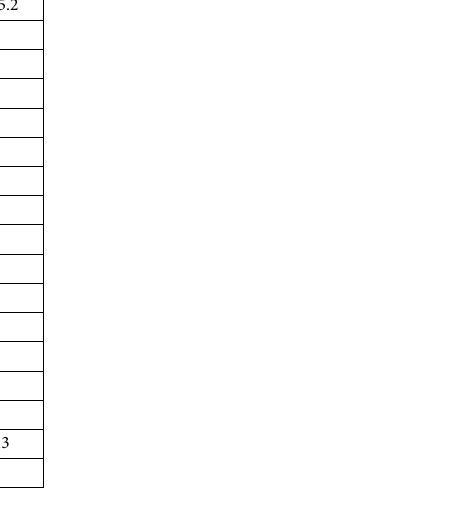
Table 1. Demographic data of the study